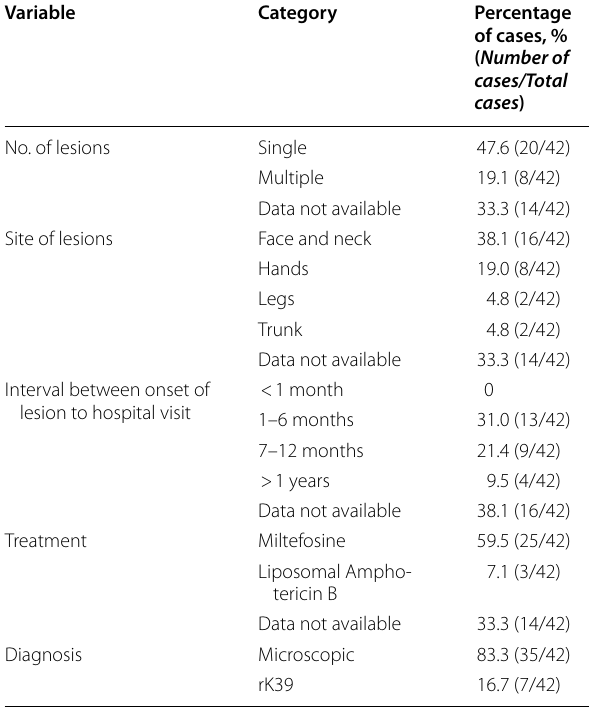
Table 2 Clinical findings of cutaneous leishmaniasis, 2016–2019 Variable